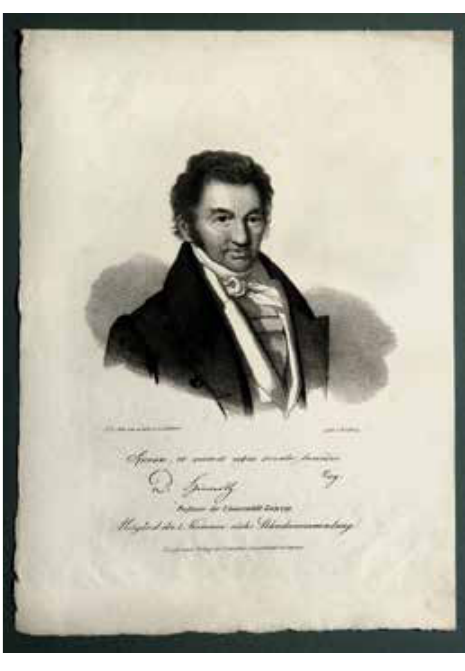
Figure 1. Johann